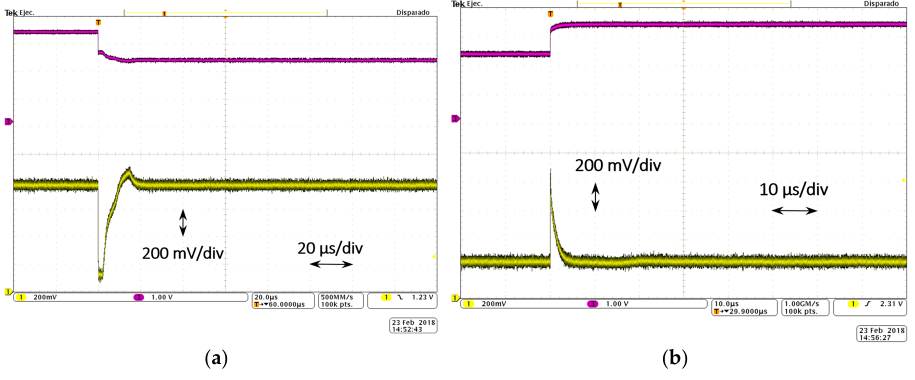
Figure 13. Line transient behavior: ( a ) undershoot response; and ( b ) overshoot